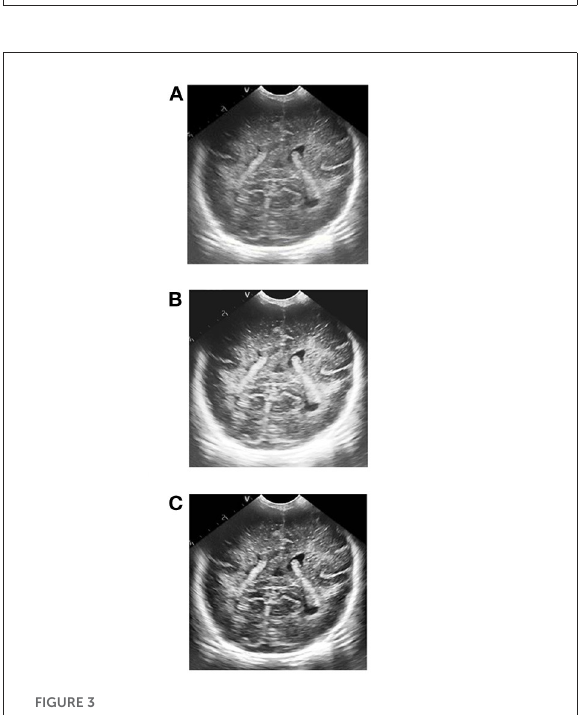
FIGURE3 Contrast enhancement effect pictures of different methods. (A) Original picture, (B) effect picture of histogram equalization, (C) CLAHE effect